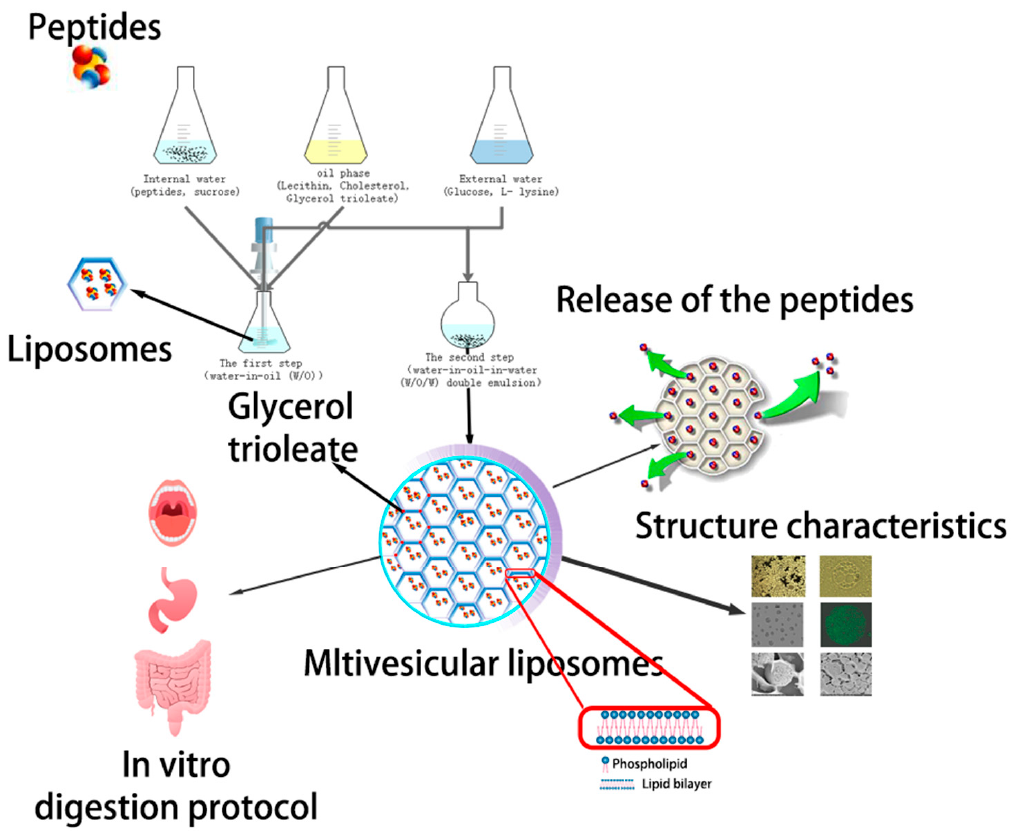
Scheme 1. Schematic diagram of the aimed controlled-release drug delivery system made of angiotensin I-converting enzyme (ACE)-inhibitory peptide multivesicular liposomes (AP-MVLs) in